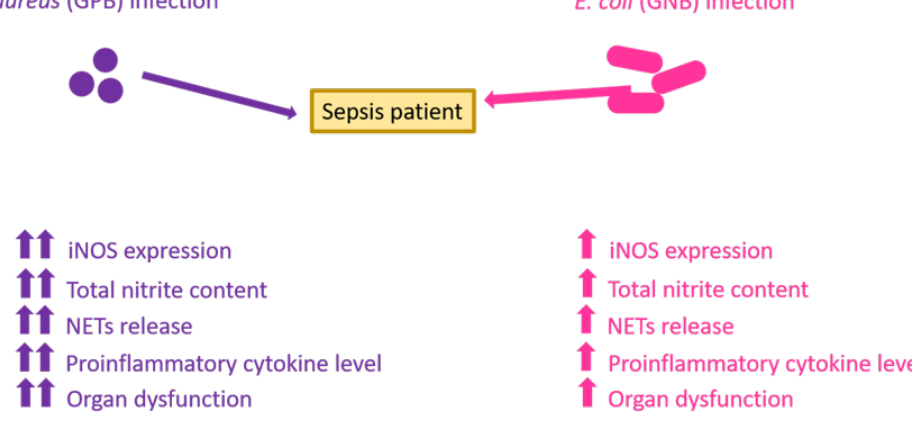
Figure 5. Schematic image representing increased host inflammatory responses (level of iNOS expression, total nitrite content, NETs release, proinflammatory cytokine level), and organ dysfunction in S. aureus (GPB) infections as compared with E. coli (GNB).